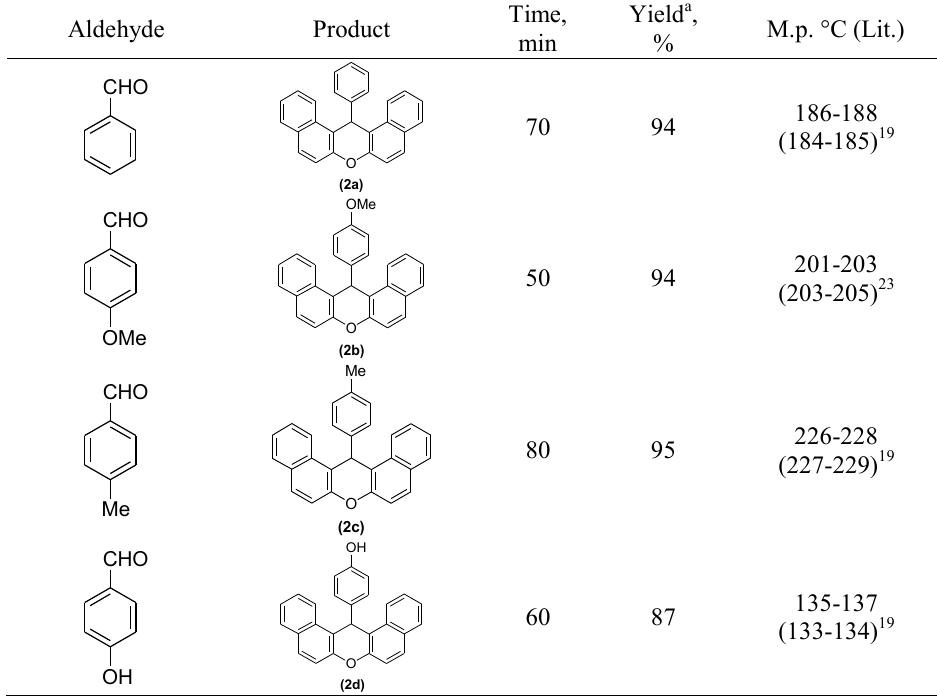
Table 4. The SaSA-catalyzed condensation of 2-naphthol with arylaldehydes leading to 14- aryl-14 H -dibenzo[ a,j